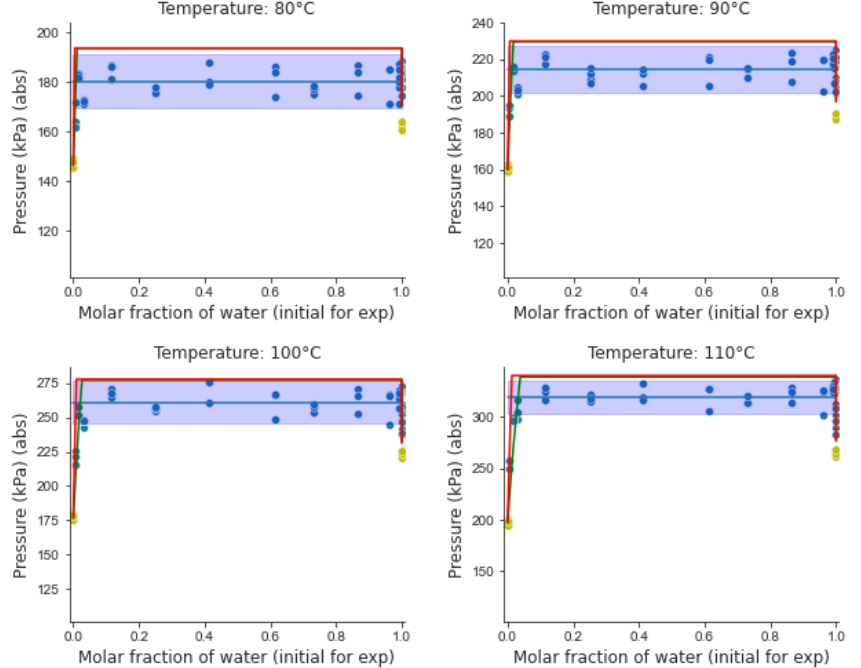
Figure 11. Comparison of P mix for the NRTL Model with Experimental Data. Notes The P mix from NRTL Aspen Plus is represented as a green horizontal line while the P mix from the NRTL from Klauck [30] is represented as a red line. Parameters reprinted with permission from Klauck, M.; Grenner, A.; Schmelzer, J. Liquid–liquid(–liquid) equilibria in ternary systems of water + cyclohexylamine + aromatic hydrocarbon (toluene or propylbenzene) or aliphatic hydrocarbon (heptane or octane). J. Chem. Eng. Data, 2006, 51 , 1043–1050, doi:10.1021/je050520f. Copyright 2021 American Chemical Society.